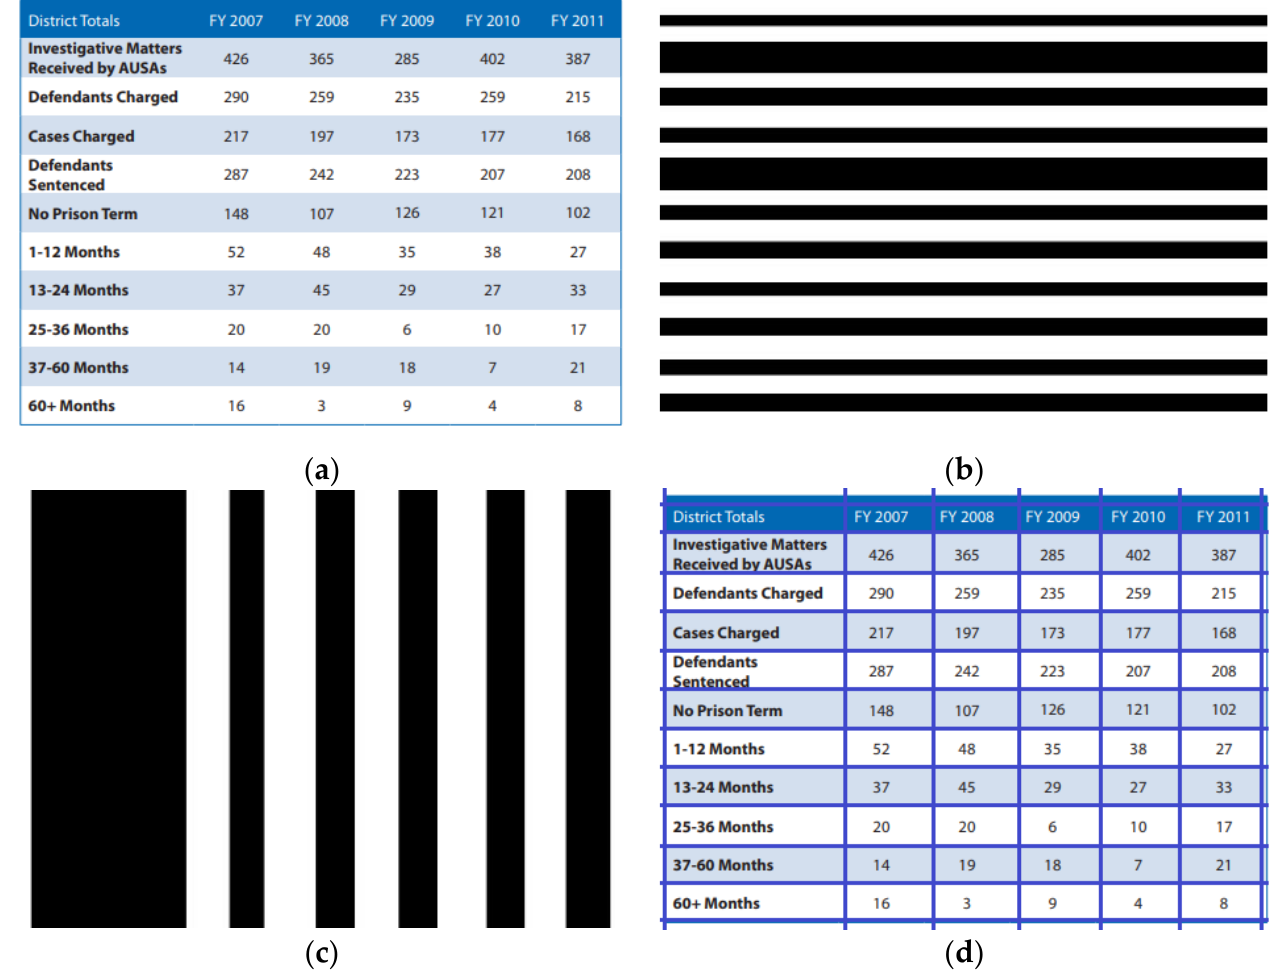
Figure 9. Prediction results visualization: ( a ) test form image; ( b ) line segmentation mask prediction map; ( c ) column segmentation mask prediction map; ( d ) visualization of the results.